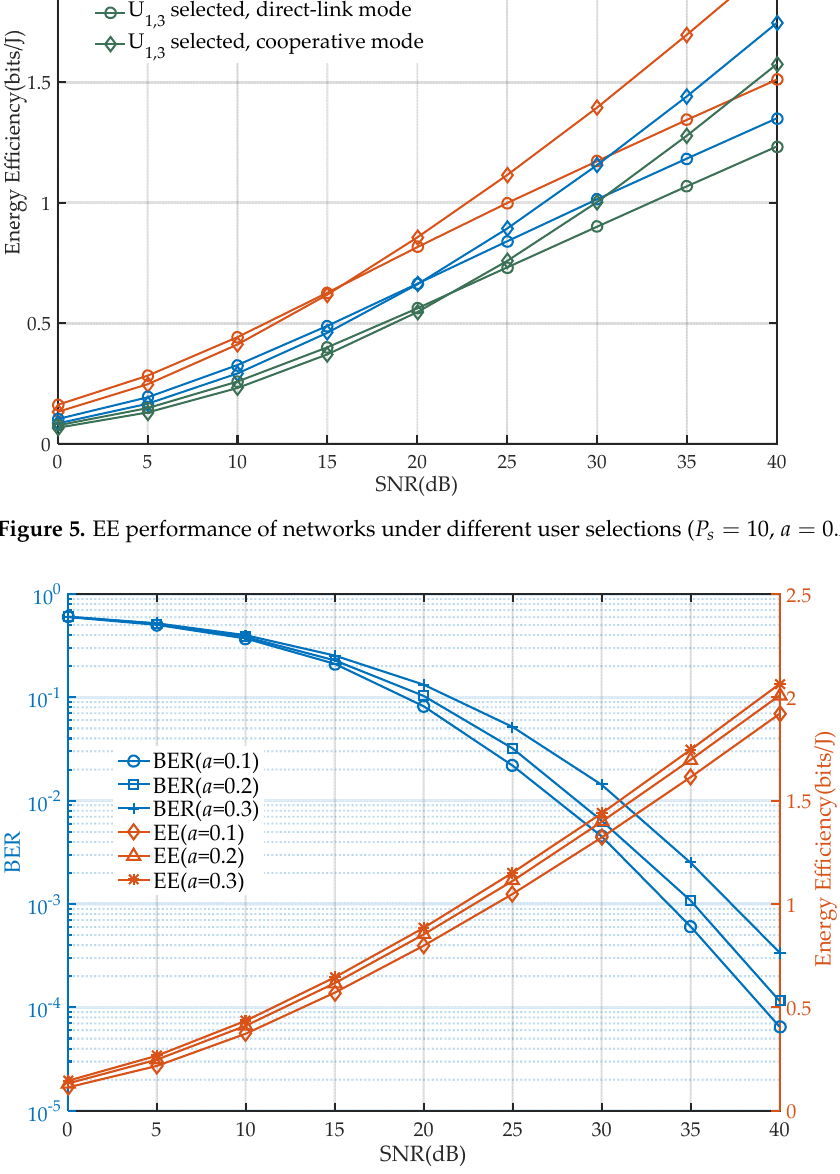
Figure 6. EE and BER performance comparison in cooperative mode under different BS power allo- cation factors ( 𝑃 (cid:3046) = 10 , 𝜌 = 0.6 ).